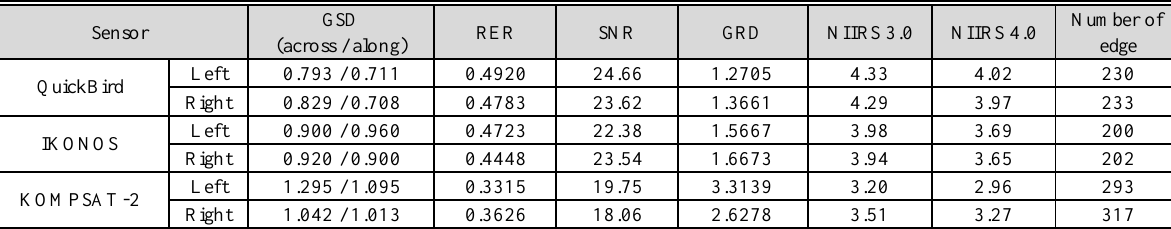
Table 4. The result of image quality